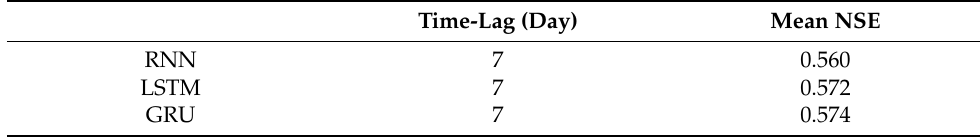
Table 3. The optimal time-lag settings at daily